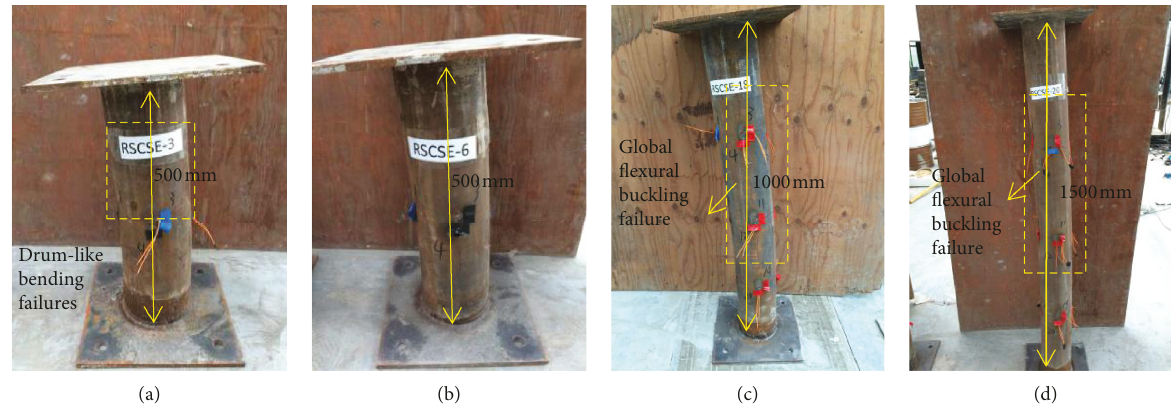
Figure 3: Failure modes of the RSCFCST columns: (a) RSCSE-3; (b) RSCSE-6; (c) RSCSE-18; (d) RSCSE-21.